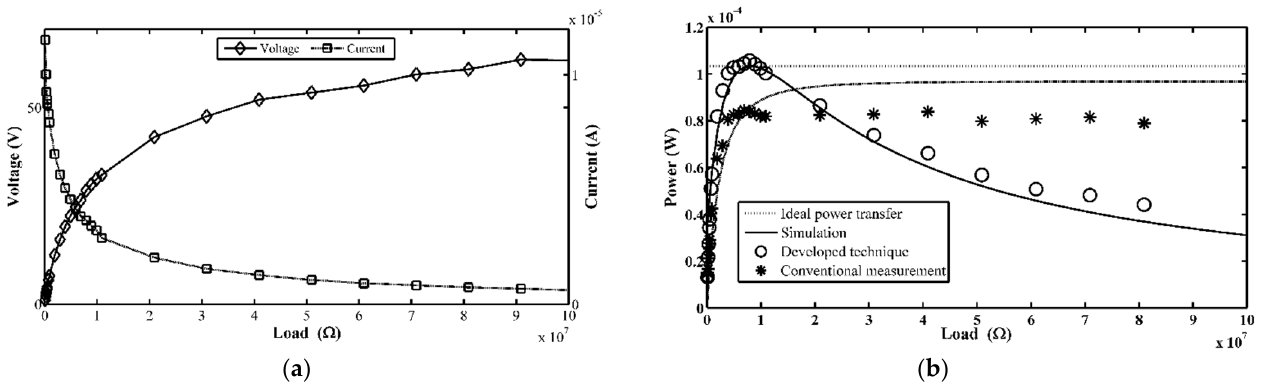
Figure 6. ( a ) Experimental results of output voltage and current; ( b ) plots of experimental results of electrical power obtained from the developed technique, results obtained from the conventional measurement technique, and ideal measurement.